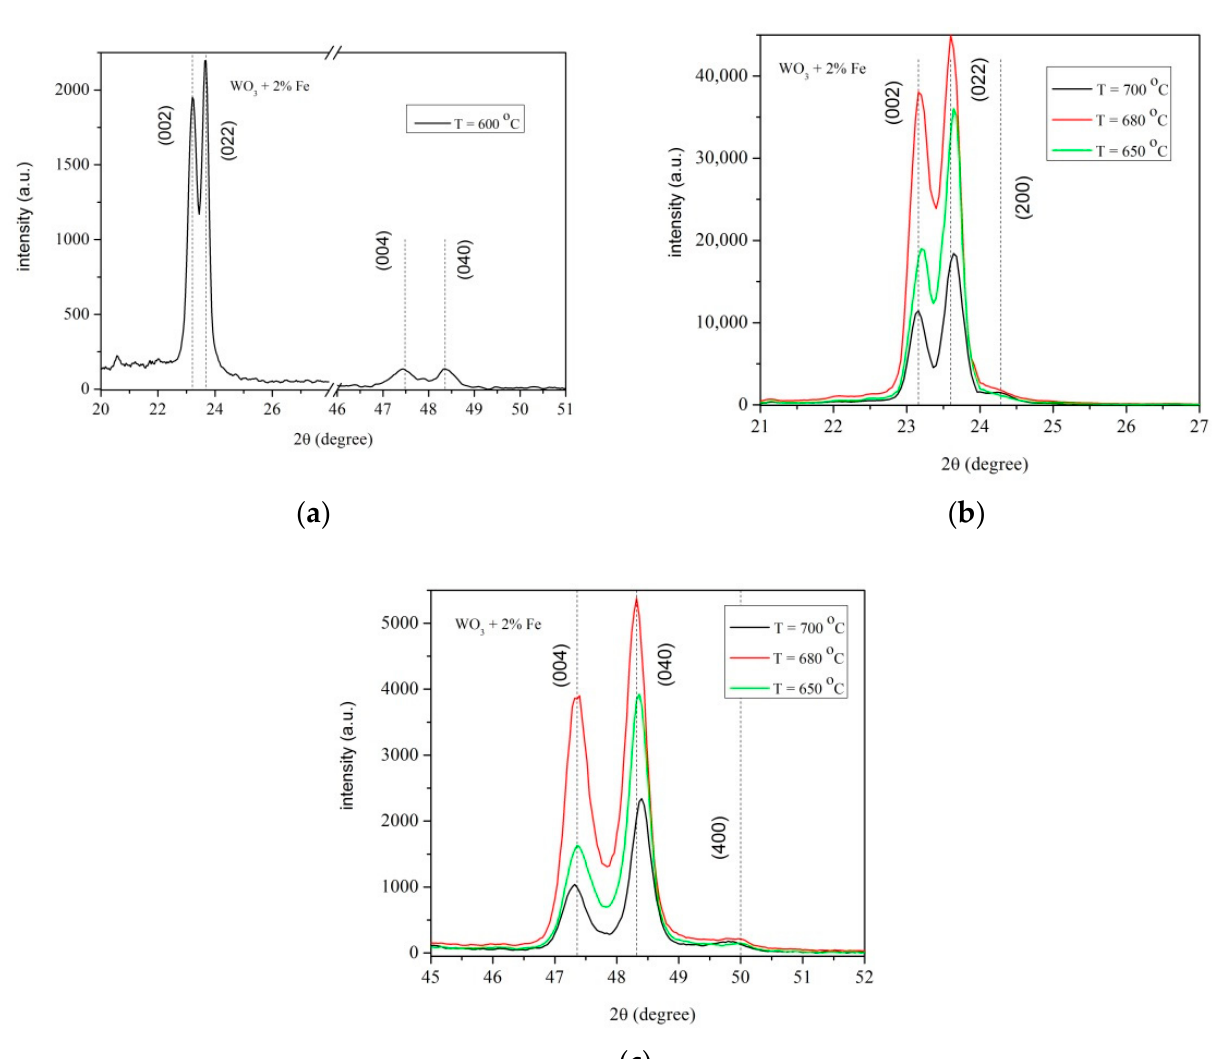
Figure 2. ( a – c ) X-ray patterns of 2%Fe doped WO 3 layers grown on sapphire substrate at various temperatures and 4 h deposition time ( a ) T = 600 °C in the range 2 θ = 20–51 °; ( b ) T = 650 °C, T = 680 °C, T = 700 °C in the range 2 θ = 21–7°; ( c ) T = 650 °C, T = 680 °C, T = 700 °C in the range 2 θ = 45–52°. The effect of Fe as a dopant is visible for 3% and 4%Fe doped WO 3 layers. The diffraction peaks (022), (200), (040) and (400), respectively for 3 and 4% Fe doped WO 3 layers vanished. To analyze the effect of Fe doped WO 3 layer, the plots are made as a function of temperature for pure/doped WO 3 for a better characterization, as seen in Figure 3a,b. Figure 3a presents a small deviation of (200)/(022) diffraction peaks compared to pure WO 3 with increasing the content of (2, 3, 4%) Fe-doped WO 3 . A small deviation of diffraction peaks (004)/(040) of Fe-doped WO 3 compare to pure WO 3 is noticed in Figure 3b. This deviation is attributed to the ionic radius of octahedral coordinated Fe 3+ of 0.64 Å, close to that of W 6+ with identical coordination number (0.60 Å) [22,23]. The crystalline field stabilization energy of octahedral coordination for Fe 3+ ion is higher than that of tetrahedral coordination. Thus, Fe 3+ ions could enter in the host lattice of WO 3 and replace W 6+ ions. The difference of the ionic radius of octahedral coordinated (0.04 Å) results in a small shift in peak positions observed in Figure 3a,b. The observed shift in peak positions of Fe-doped WO 3 compared to pure WO 3 can be attributed to the small difference between of W 6+ and Fe 3+ ionic radii. The Fe 3+ ionic radius being a little